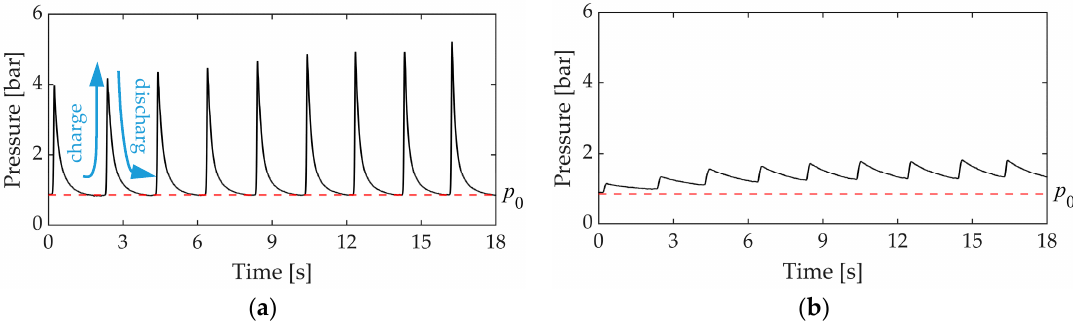
Figure 3. Experimental pressure variation in charge/discharge stages of the CAV, for Re = 155,000: ( a ) volume fraction ratio (VFR) = 8.33%; ( b ) VFR = 66.67%.